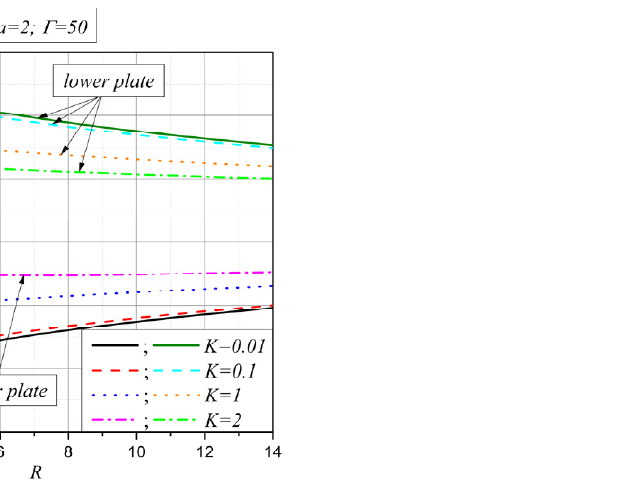
Figure 16. Dimensionless temperature 𝜃 for different values of porosity parameter 𝑅 .